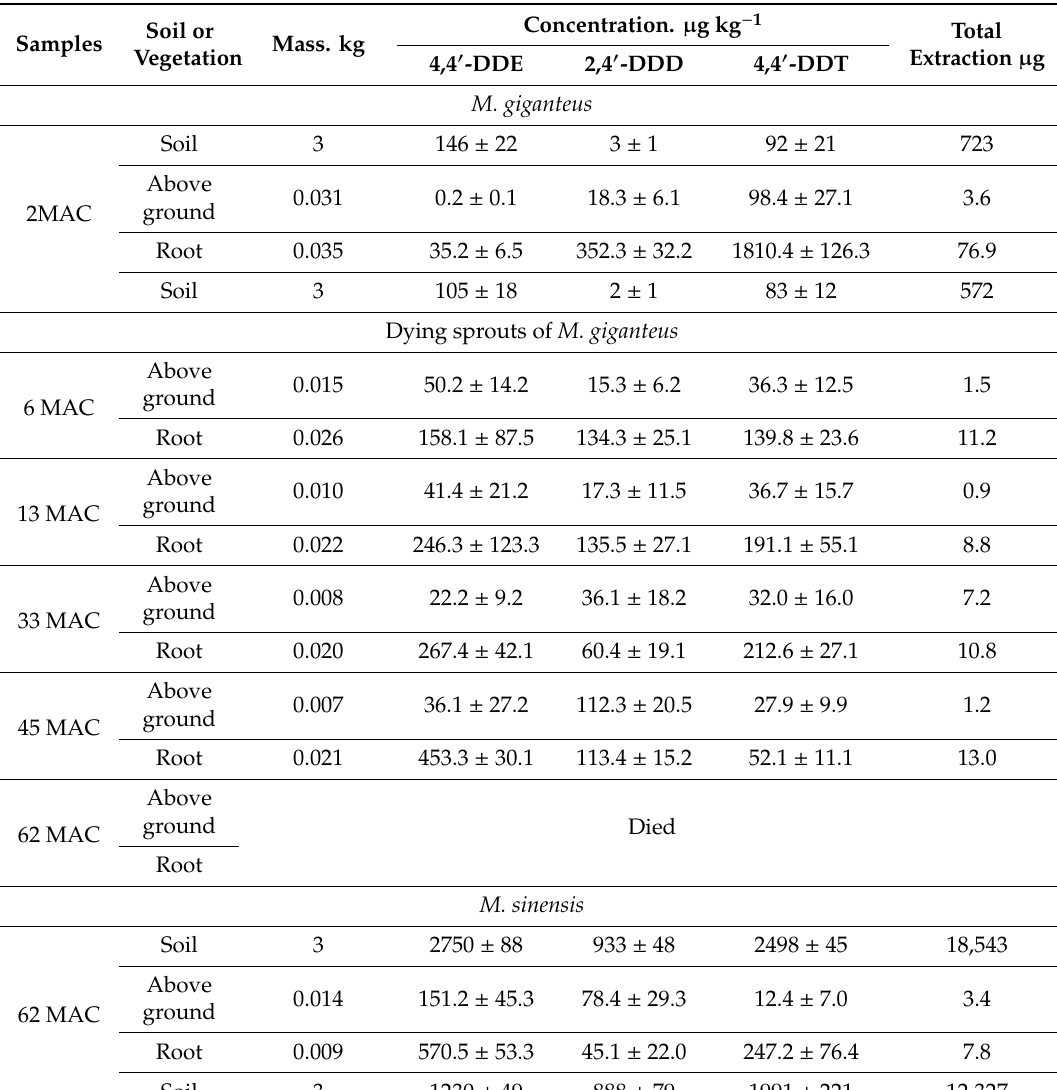
Table 1. The concentration of DDT (1,1,1-trichloro-2,2-bis(p-chlorophenyl) ethane) and metabolites in soil and miscanthus after phytoremediation during one growing season